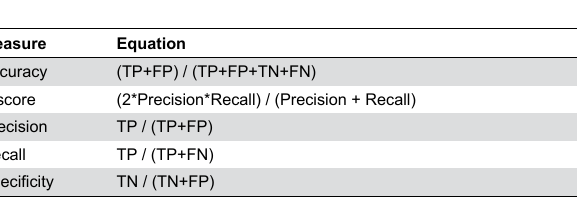
Table 3. Classification performance